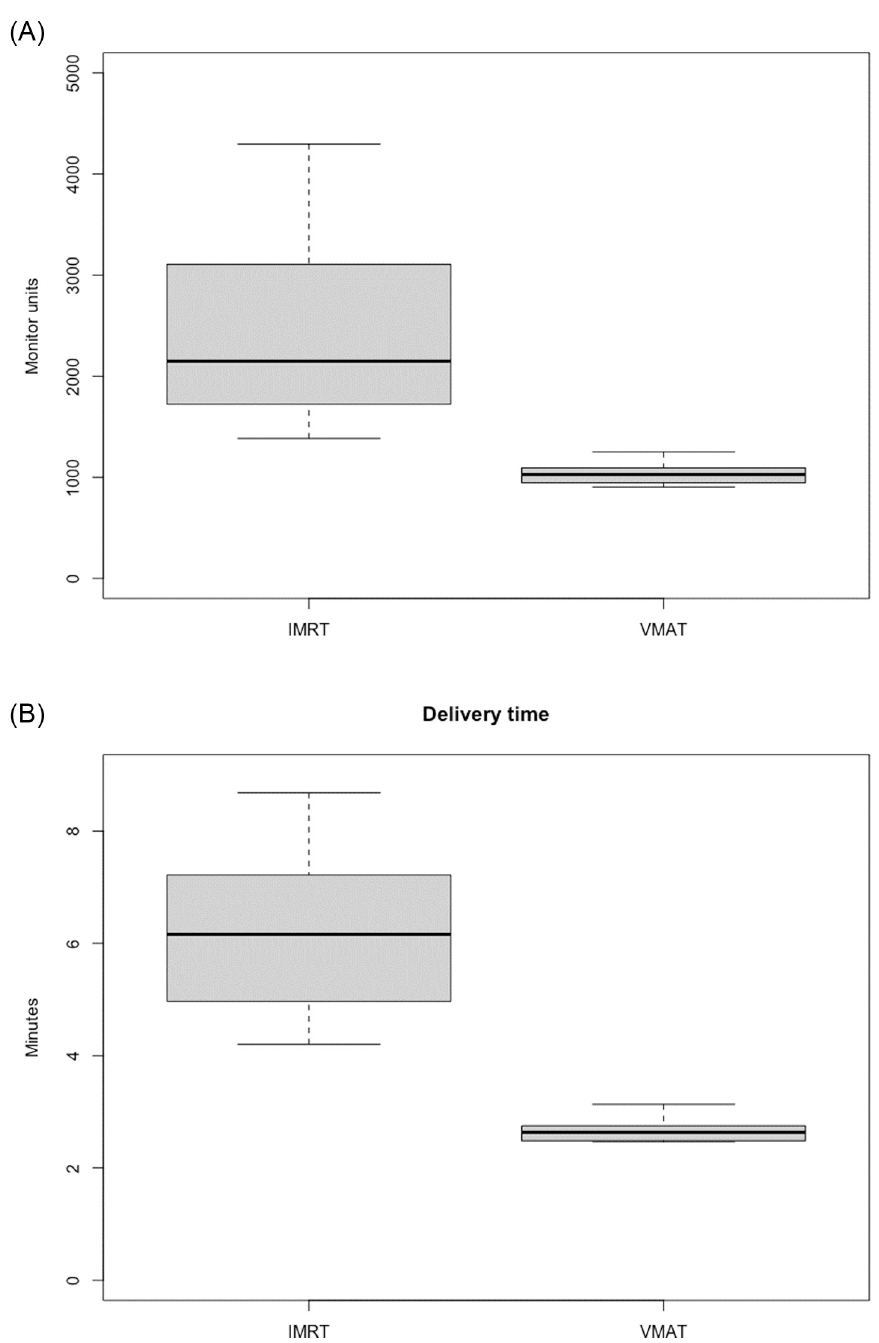
Fig 3. Mean monitor units and delivery time. Monitor units and delivery time of fixed-field IMRT versus VMAT plans: (A) The mean number of monitor units was significantly higher for fixed-field IMRT (2446.0 ( ± 1015.5)) versus VMAT plans (1033.2 ( ± 107.8)) (p < 0.01). (B) The median delivery time for fixed-field IMRT plans (6.16 minutes, IQR 2.2) was significantly longer compared to VMAT plans (2.63 minutes, IQR 0.25) (p < 0.01). IMRT: Intensity modulated radiation therapy; VMAT: Volumetric modulated arc therapy.